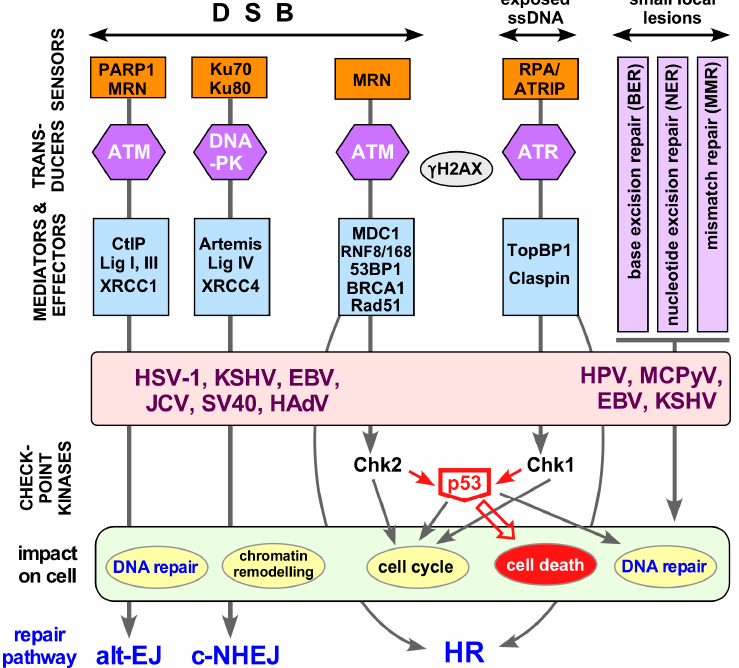
Figure 6. The host DNA damage repair response and viral interference. Double-strand DNA breaks (DSBs), exposed single stranded DNA (ssDNA) at collapsed replication forks and various kinds of local DNA lesions are detected by sensors that mark the site of damage. Transducers, and mediator plus effector proteins transmit and amplify the signal throughout the cell, resulting in a huge influx of factors to repair damage and remodel chromatin. The key apical transducer kinases are ATM (Ataxia telangiectasia mutated), ATR (Ataxia telangiectasia and Rad3-related), and DNA-PK (DNA-dependent protein kinase). These Ser/Thr kinases regulate DNA replication, DNA repair, cell-cycle checkpoint control (e.g., via Chk1, Chk2), and if necessary cell death (e.g., via p53) by recruitment of specific effector proteins. A hallmark of the DNA damage respone (DDR) is phosphorylation of histone H2AX to generate γ H2AX, and the formation of large γ H2AX foci around the site of damage. c-NHEJ and alt-EJ are error-prone and always active; high-fidelity repair via homologous recombination (HR) requires an intact sister chromatide as template and thus is largely restricted to the S and G2 phases of the cell cycle. More and more viruses are known to exhibit a complex relationship with the DDR [101,106] to maintain efficient viral replication and onset of gene expression. Only some well established DNA virus examples are shown (HSV-1, herpes simplex virus type 1; EBV, Epstein-Barr-virus; KSHV; Kaposi’s sarcoma herpesvirus; JCV, JC virus; SV40, simian virus 40; HPV, human papillomavirus; MCPyV; Merkel cell polyomavirus; HAdV, human adenovirus) but RNA viruses are joining the list [99]. See text for further details. Abbreviations: 53BP1, P53-binding protein 1; BRCA1, Breast cancer susceptibility gene 1; Chk, Checkpoint kinase; CtIP, C-terminal interacting protein; DSB, double-strand DNA break; MDC1, Mediator of DNA damage checkpoint; PARP1, poly ADP ribose polymerase 1; RNF, Ring finger protein; TopBP1, topoisomerase-IIbeta-binding protein 1; XRCC, X-ray repair complementing defective repair in Chinese hamster cells